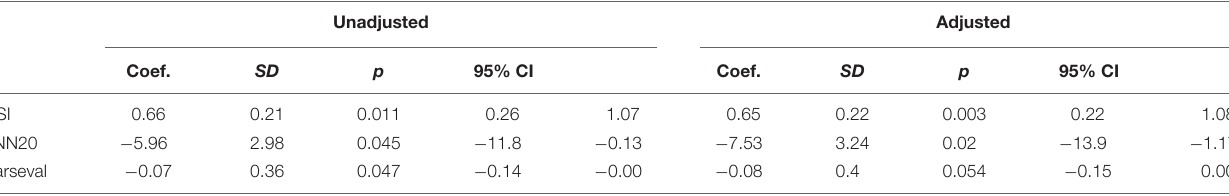
TABLE 6 | Unadjusted and adjusted correlation between HRV metrics and reduced fetal movements. Unadjusted Coef.